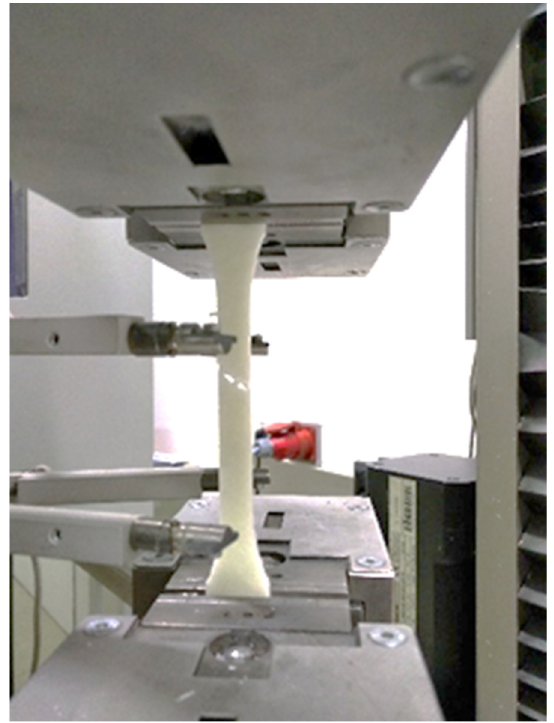
Figure 5. Tensile test according to ISO 527 on machined out standard test specimens of the PP/GF30 injection molded short fiber-reinforced thermoplastic composite.